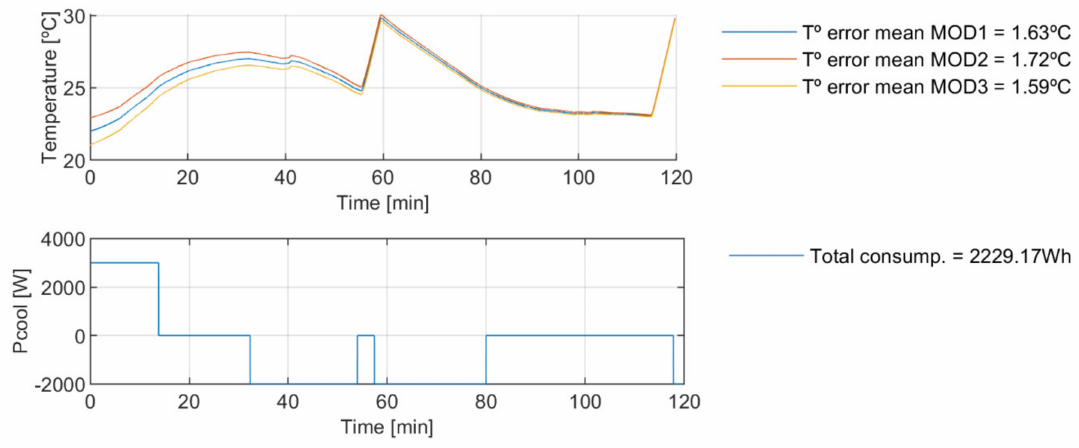
Figure 8. Proposed state diagram controller applied to the use case.